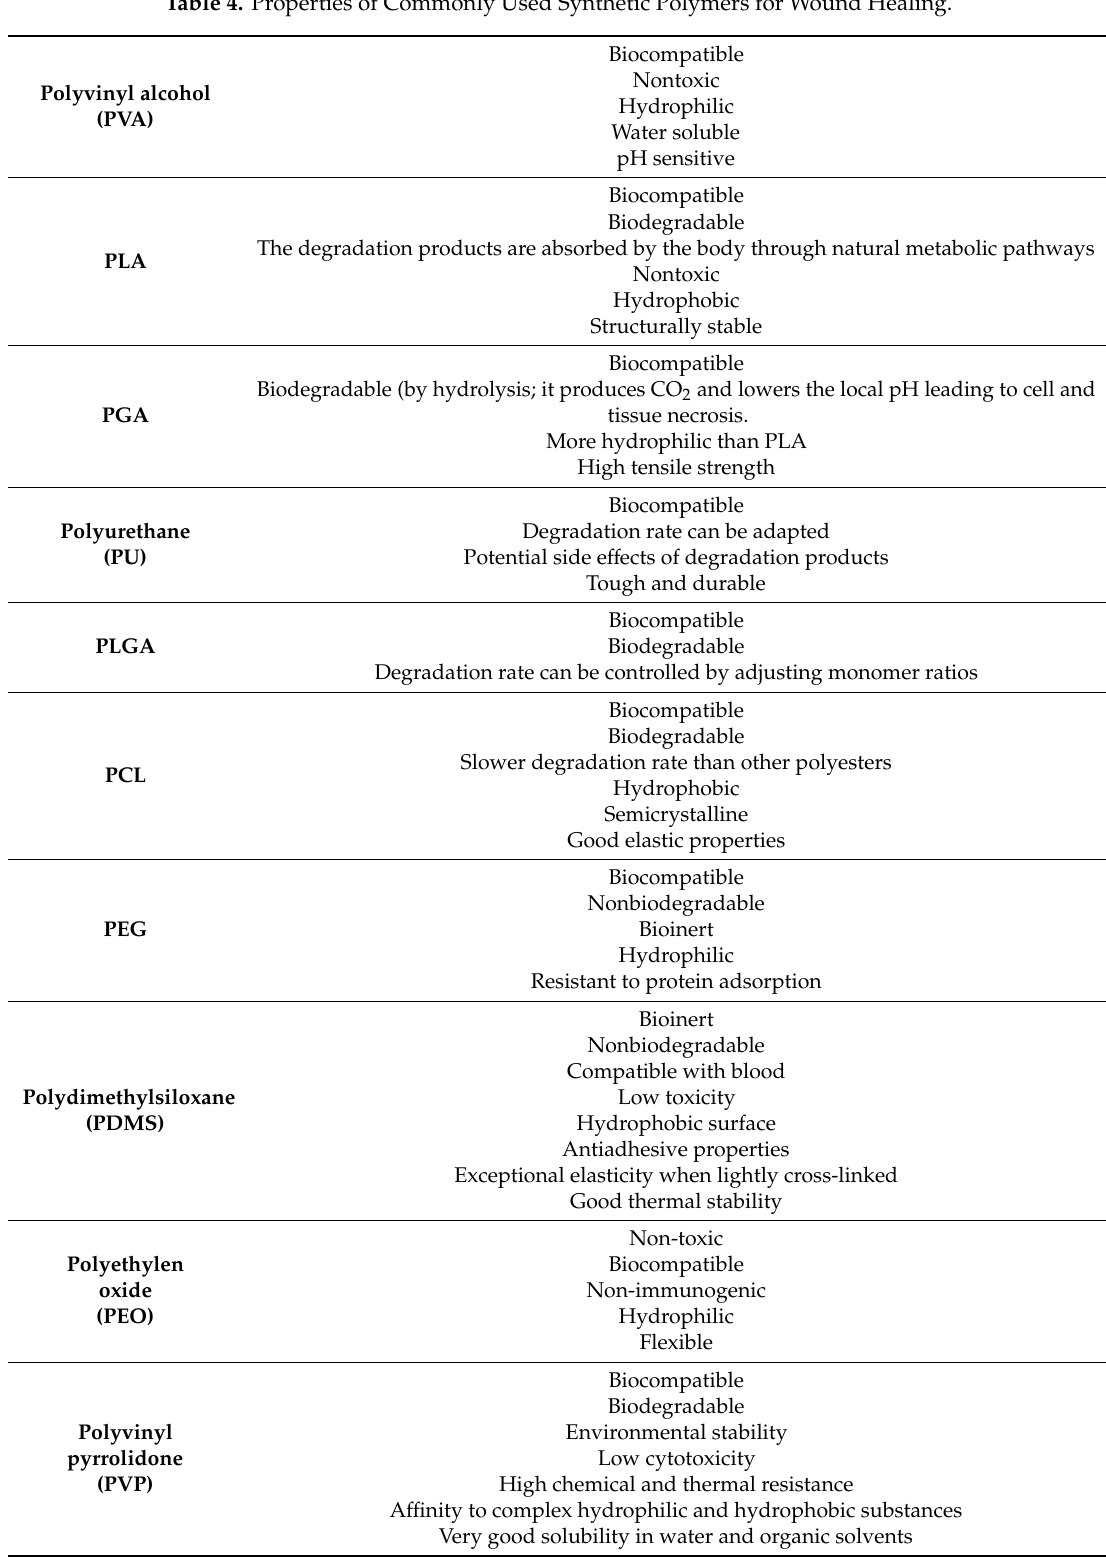
Table 4. Properties of Commonly Used Synthetic Polymers for Wound Healing.